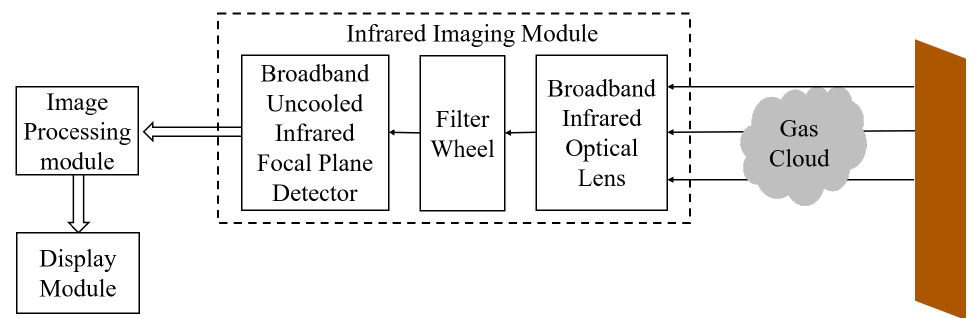
Figure 1. Block diagram of broadband infrared spectral imaging